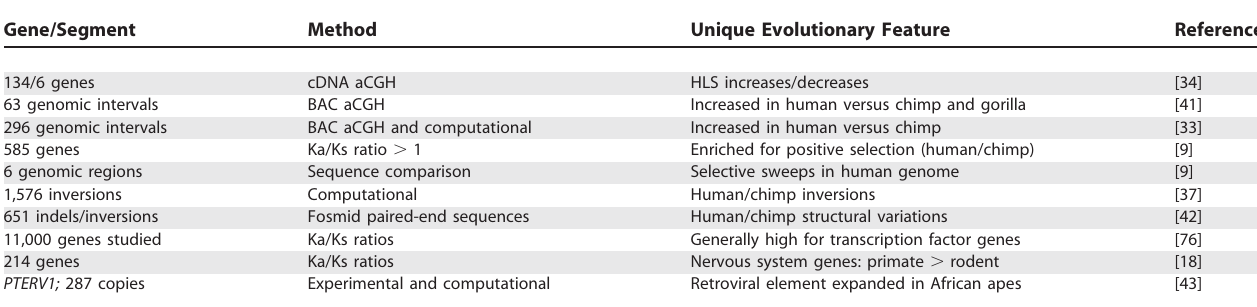
Table 3. Recent Cross-Species Genome-Wide Sequence and Structural Variation Studies Gene/Segment